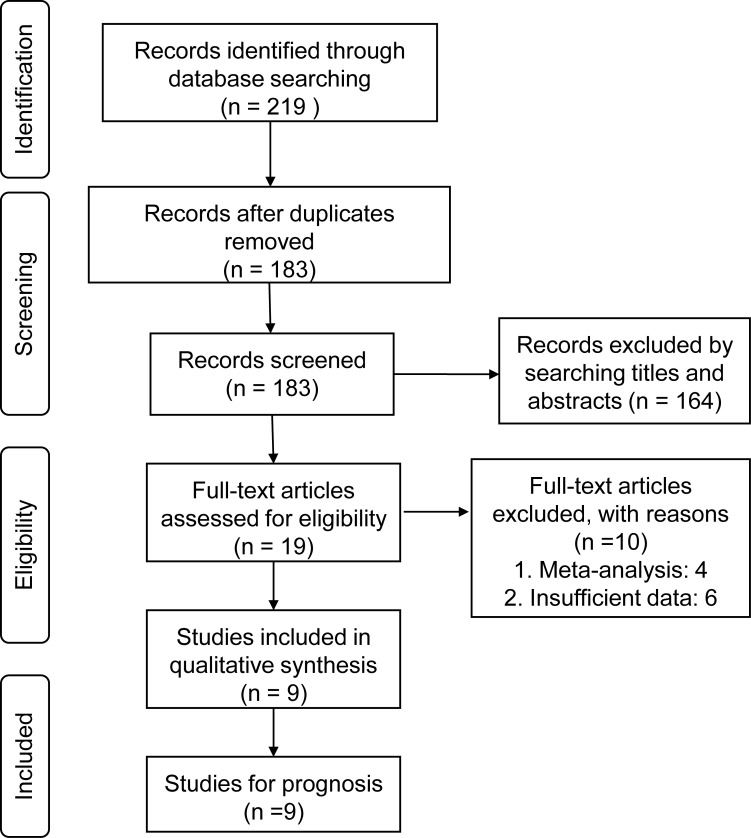
Flow chart of literature selection process in the meta-analysis.